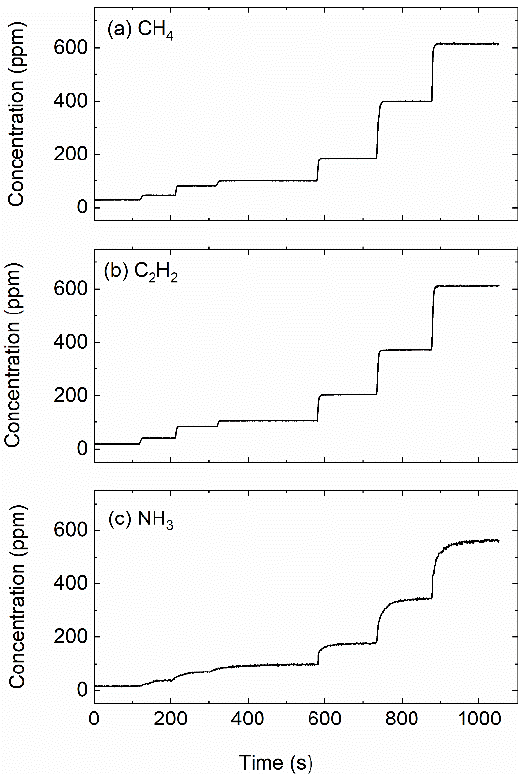
Figure 9. Gas flow test of the sensor for CH 4 ( a ), C 2 H 2 ( b ) and NH 3 ( c ) at different concentrations.